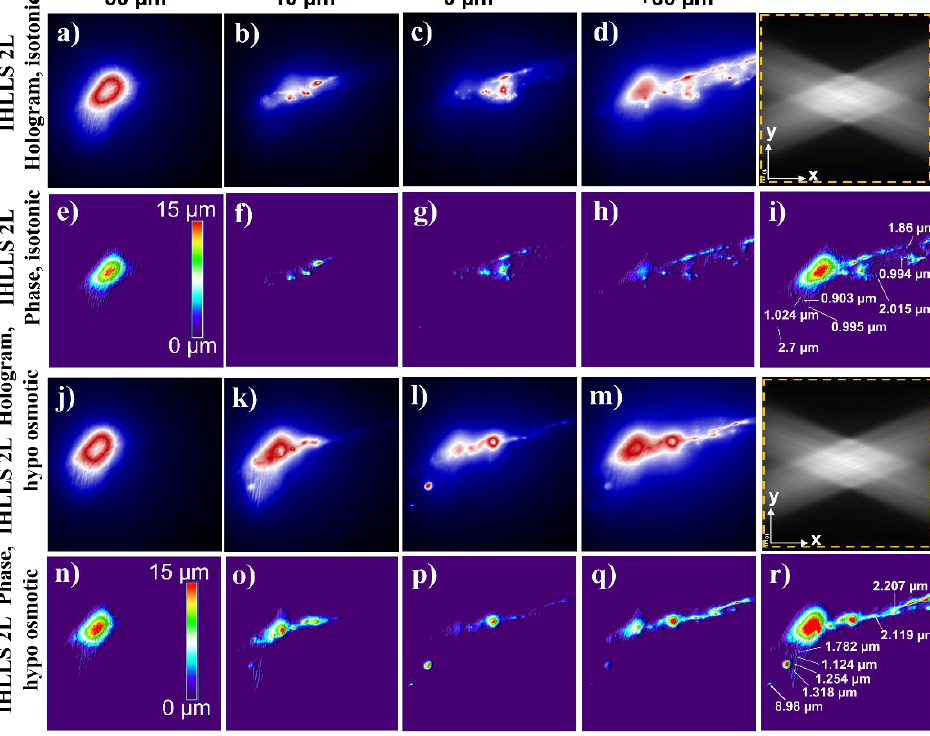
Figure 4. IHLLS 2L imaging of a lamprey spinal cord ventral horn neuron with dendrites in a Ringer’s solution ( a – i ) and hypotonic solution ( j – r ), FOV 208 × 208 µ m 2 , 2048 × 2048 pixels; ( a – d , j – m ) imaging holography at − 30 µ m, − 10 µ m, 0 µ m, and + 30 µ m, for the phase-shift θ =